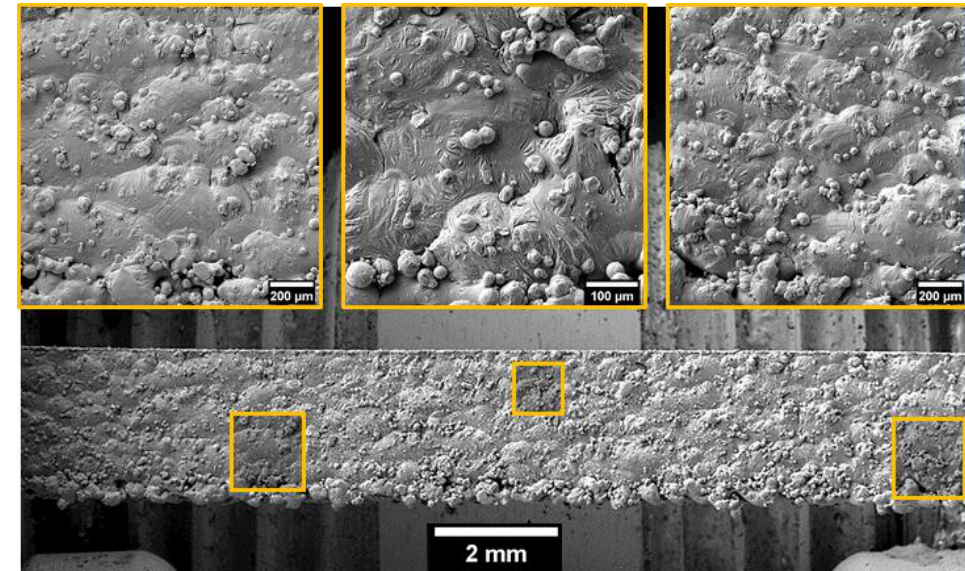
Figure 10. Surface appearance of X-Z sample with structure specification.